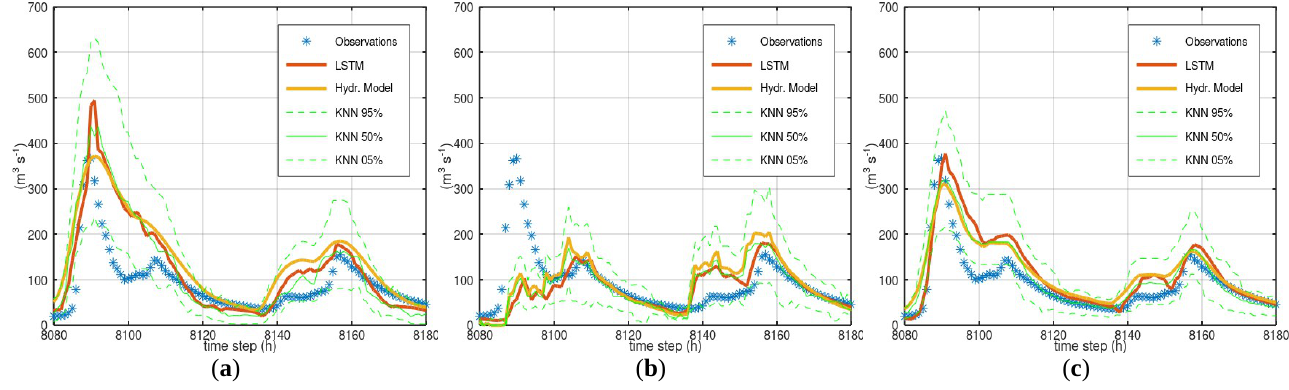
Figure 8. Simulation of Sieve River, for time steps 8080–8180 of the test period: ( a ) HYMOD; ( b ) LRHM (note the confidence interval between time steps 8080 and 8100); and ( c )